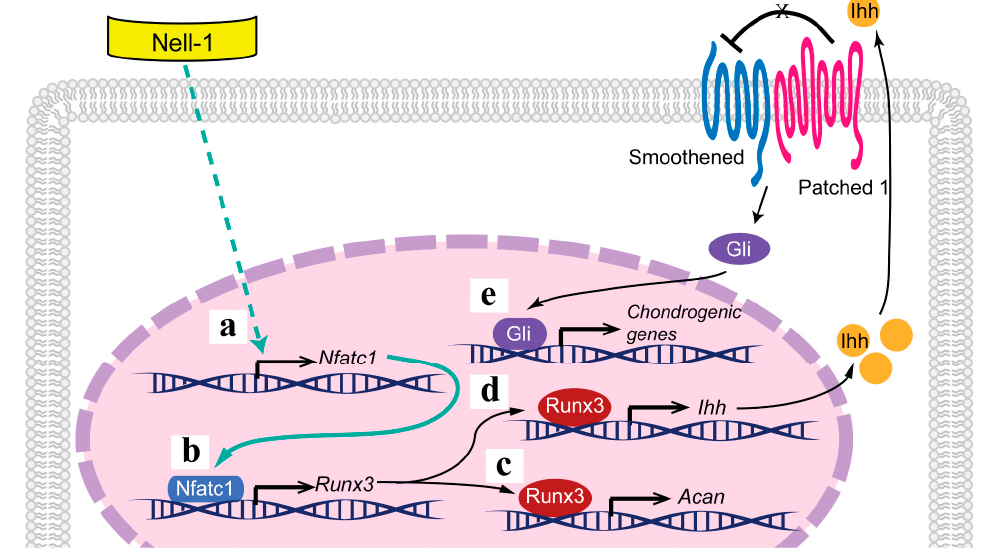
Figure 6. Schematic diagram of Nell-1 signaling pathways during chondrogenesis. ( a ) Nell-1 promotes Nfatc1 expression; ( b ) Nfatc1 next binds to the promoter of Runx3, activating the Runx3 signal transduction ( c ) as well as the Ihh signal transduction ( d ) to stimulate the differentiation and maturation of chondrocytes ( e ). Black arrows, previously revealed knowledge; green solid arrow, current uncovered regulation mechanism; green dashed arrow, a current suggested regulation mechanism which needs further investigation; T bar, known inhibitory effect.